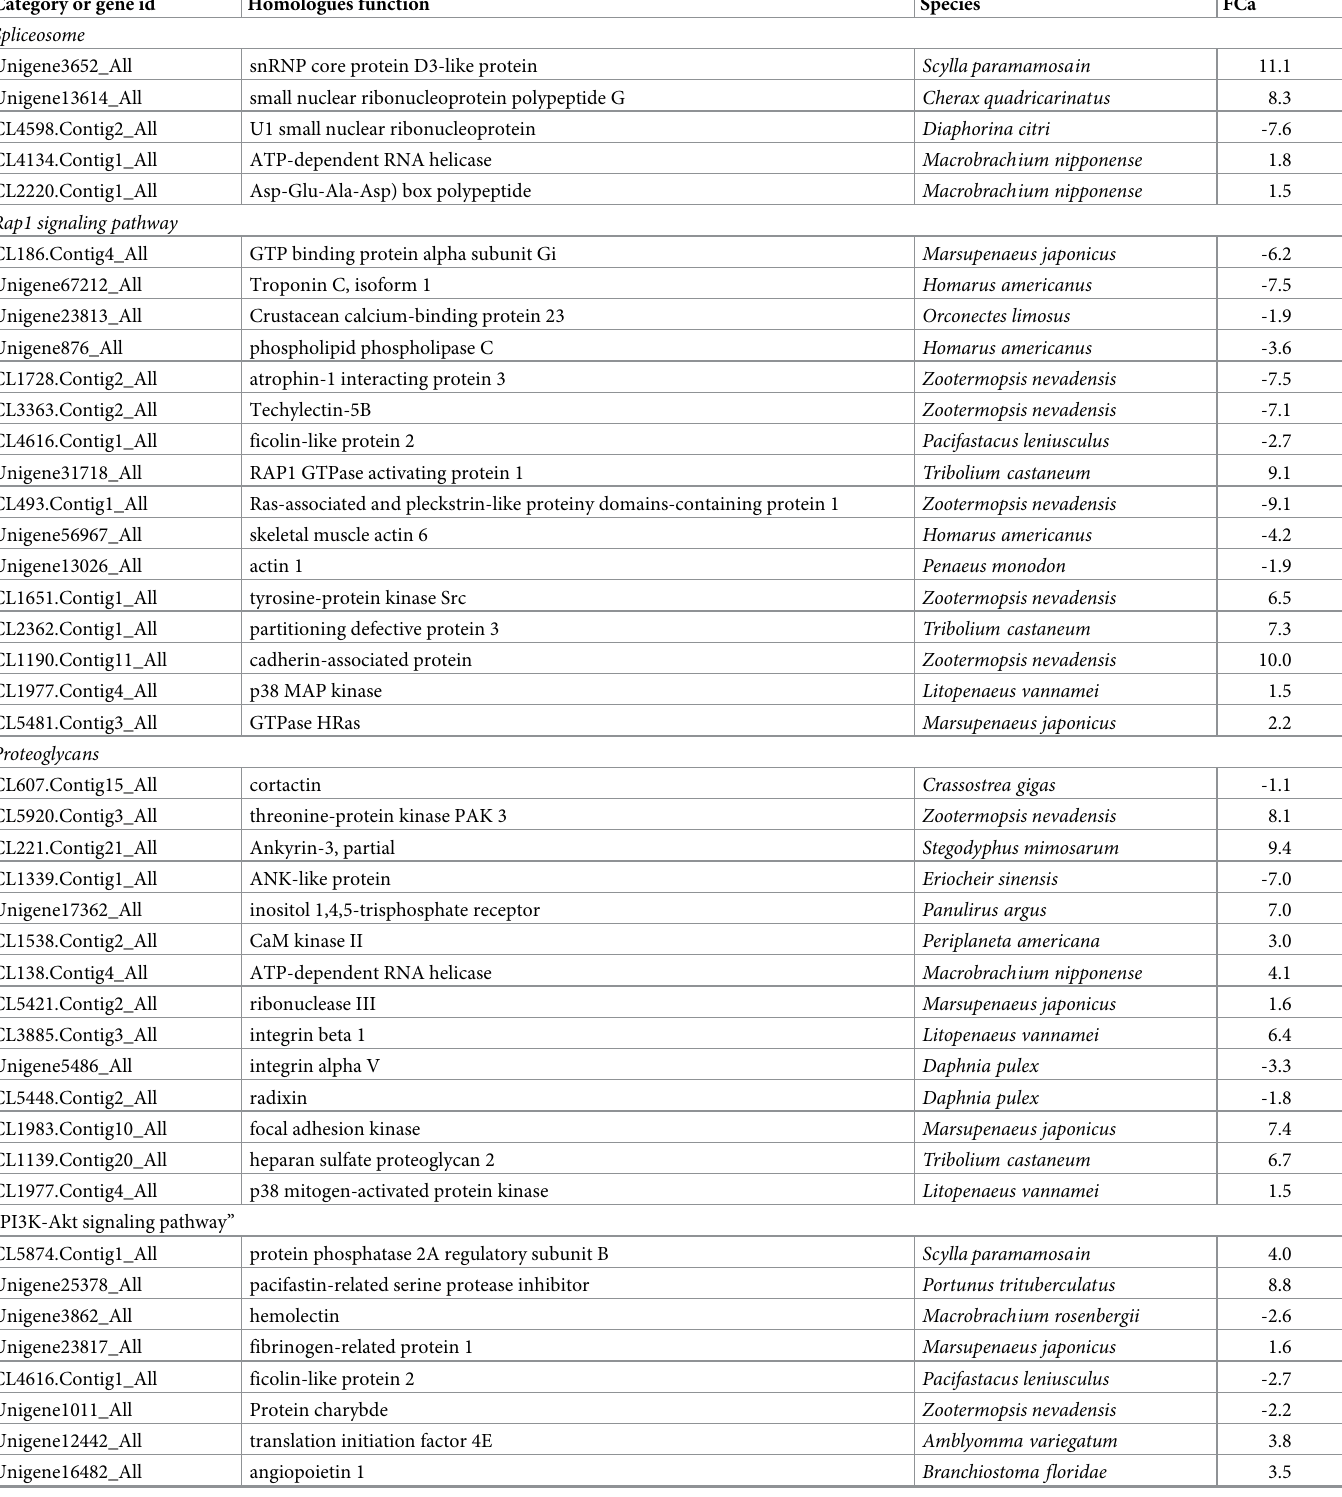
Table 2. Selected intestine-specific DEGs potentially involved in Macrobrachium rosenbergii immune response against viral